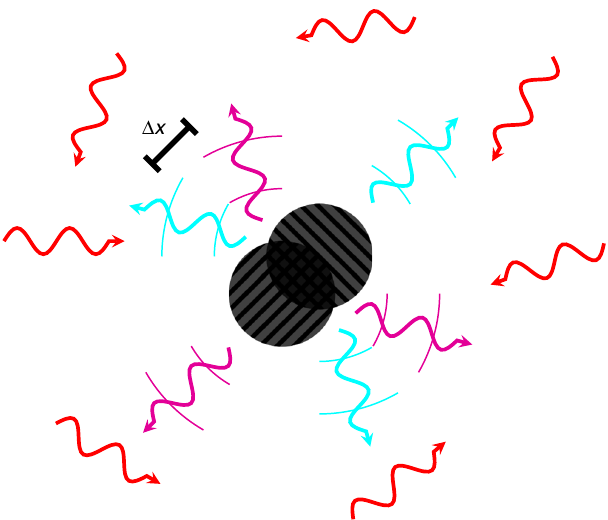
Fig. 1 A black hole in a superposition of two position states with separation Δ x , immersed in a thermal bath of massless quanta. The quanta from the thermal bath are shown in red. Information about the location of the black hole is carried off by scattered and emitted quanta, shown in cyan and purple for the two different